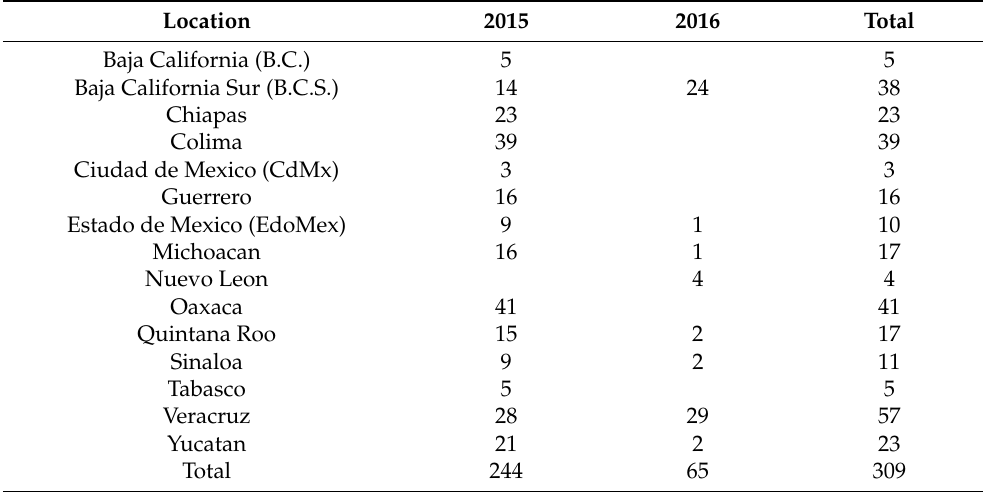
Table 1. Numbers and location origins of serum samples used in this